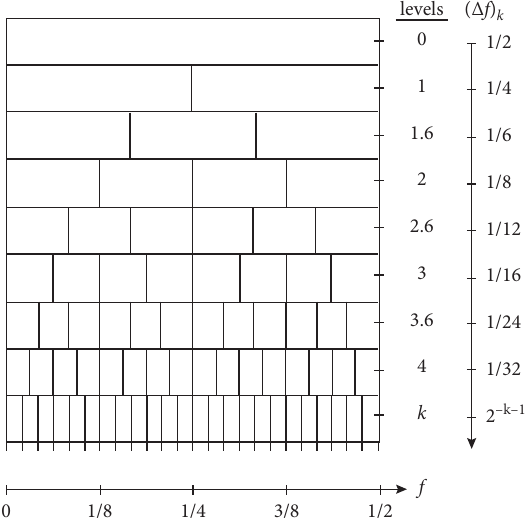
Figure 2: Paving of the plane in case of 1/3-binary tree kurtogram estimator proposed by Antoni